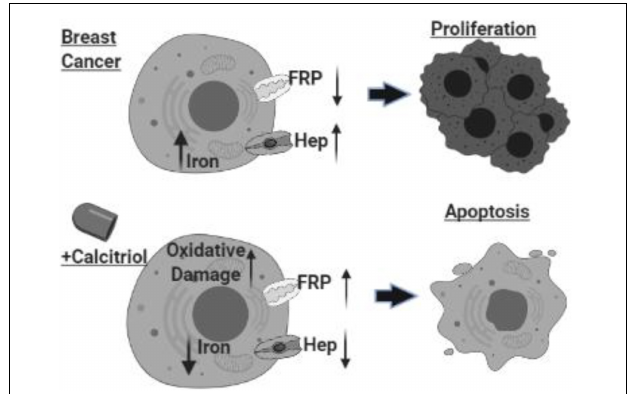
FIGURE 9 | Schematic illustration of study conclusion. Created with